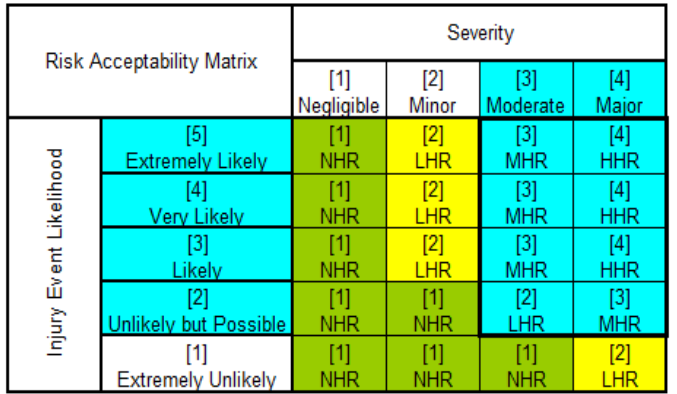
Figure 2. EDO Assignment to evaluate risk to patient or operator of the IVD device—Authors own work. Legend: (1) NHR: Negligible Risk; (2) LHR: Low Risk; (3) MHR: Medium Risk; (4) HHR: High Risk; EDO: Turquoise Blue. NHR and LHR does not require professional medical intervention.